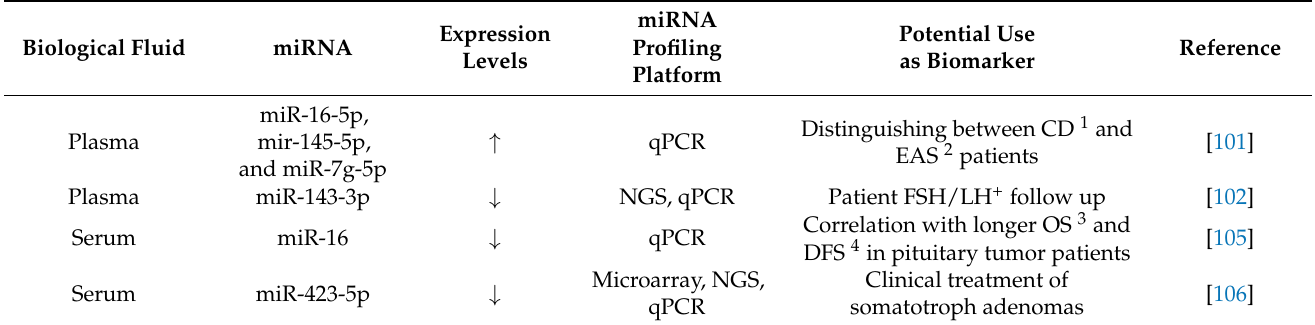
Table 8. Summary of differentially expressed c-miRNAs in